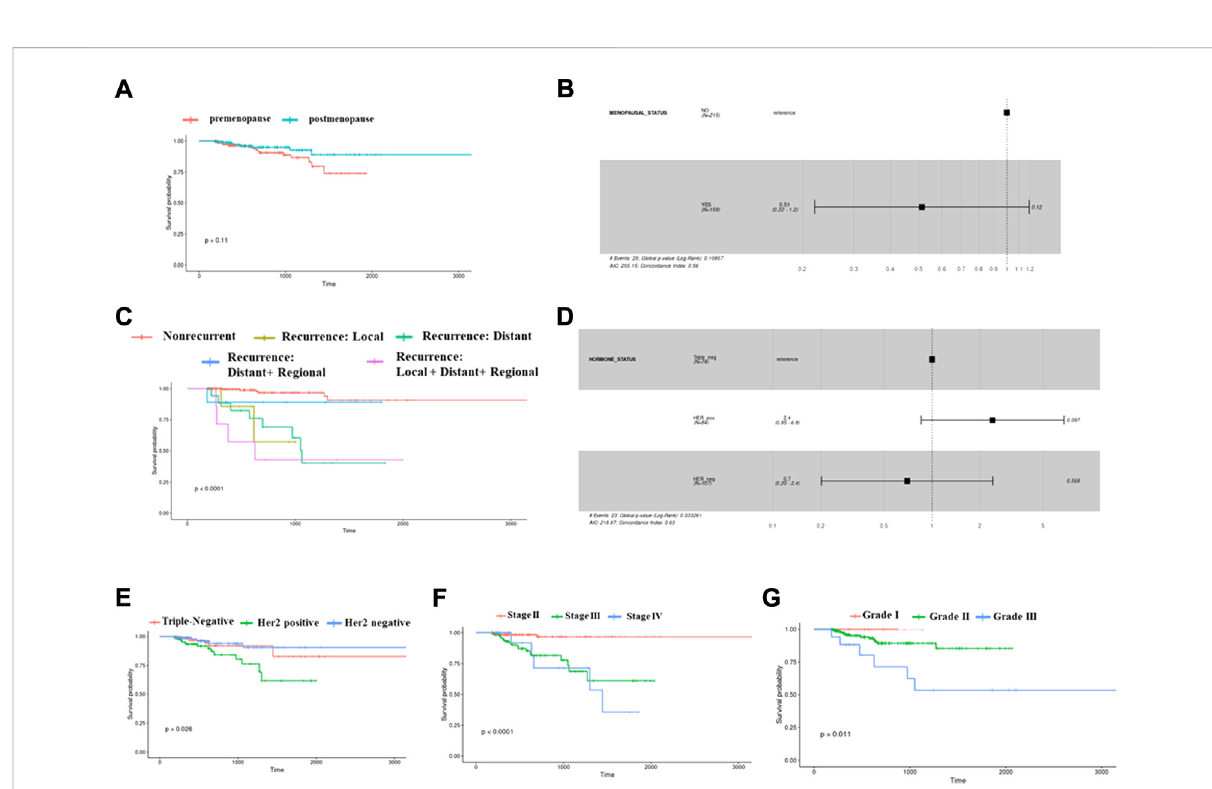
FIGURE 1 Kaplan – Meier survival plots showing differences in probabilities between various clinical parameters. (A) This plot depicts a low survival for postmenopausal samples compared to premenopausal women samples. (B) Cox-proportional hazard ratios plot showing signi fi cant variations between pre- and postmenopausal status. (C) This survival plot shows differential probabilities between different types of recurrent and nonrecurrentsamples. (D) Cox-proportionalhazardratiosplotshowingsigni fi cantvariationsbetweentriple-negative,Her2-positive,andHer2- negative subtypes of breast cancer. (E) Survival plot for triple-negative, Her2-positive, and Her2-negative subtypes of breast cancer. (F) Survival plot for different stages of breast cancer. (G) The plot is for displaying different survival probabilities for samples belonging to different tumor